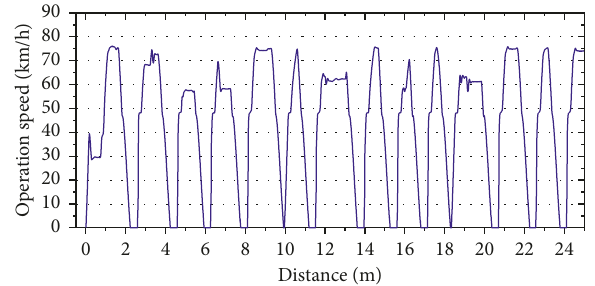
Figure 3: Distribution of metro train operation speeds.